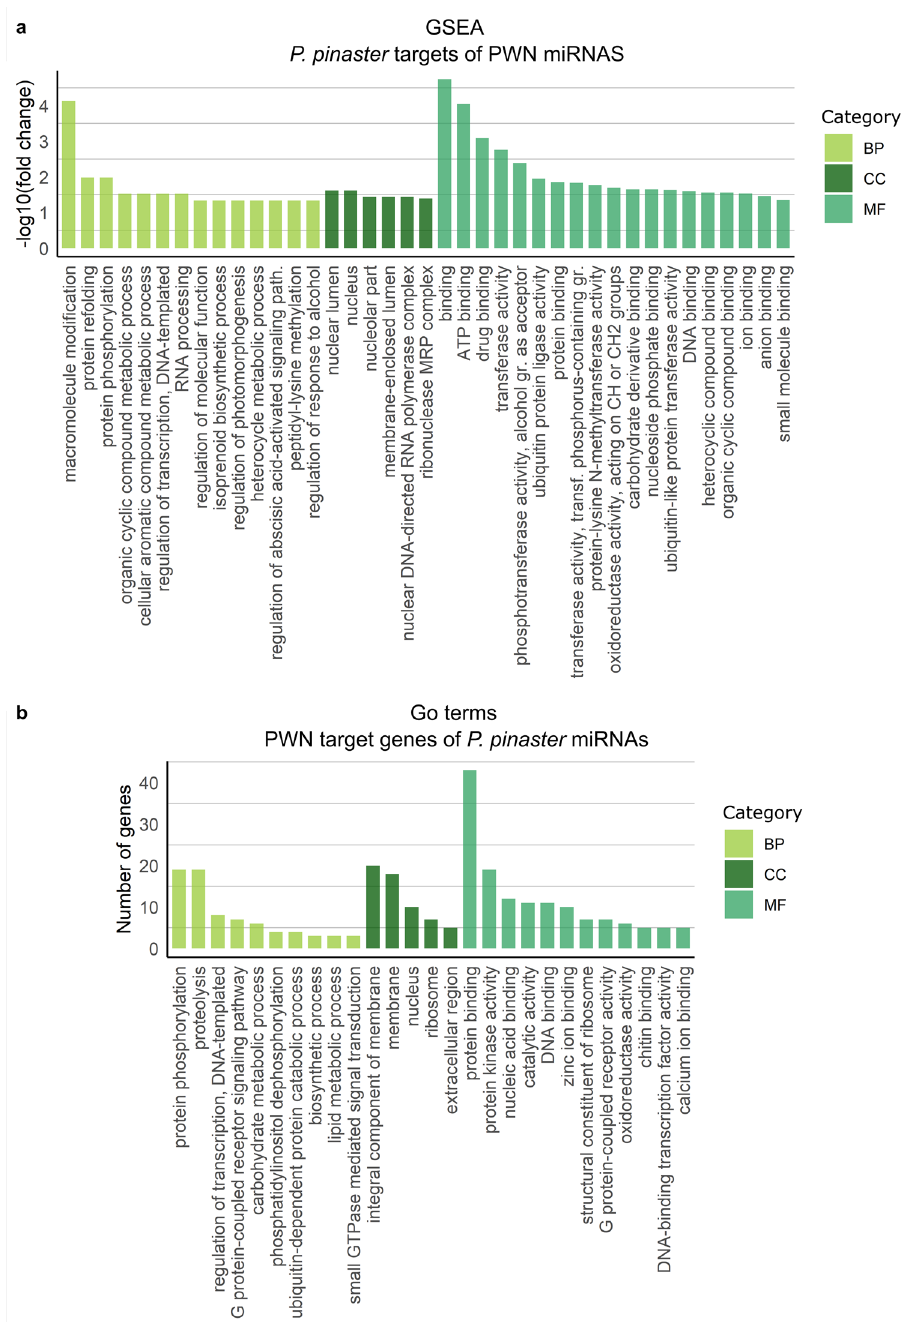
Figure 4. Functional analysis of the predicted target genes of miRNAs possibly involved in trans-kingdom interaction. ( a ) Gene set enrichment analysis (GSEA) of GO terms represented in P. pinaster predicted targets for PWN miRNAs. The y-axis represents the significance of pathway enrichment (− log10 of corrected p -values). ( b ) GO terms represented in PWN predicted target genes for P. pinaster miRNAs. The y-axis represents the number of genes within each GO terms. Plots were generated with R 4.1.0 (https:// cran.r- proje ct. org/) ggplot2 package (https:// ggplo t2. tidyv erse. org/). Inkscape 1.1 (https:// inksc ape. org/) was used to assemble the final